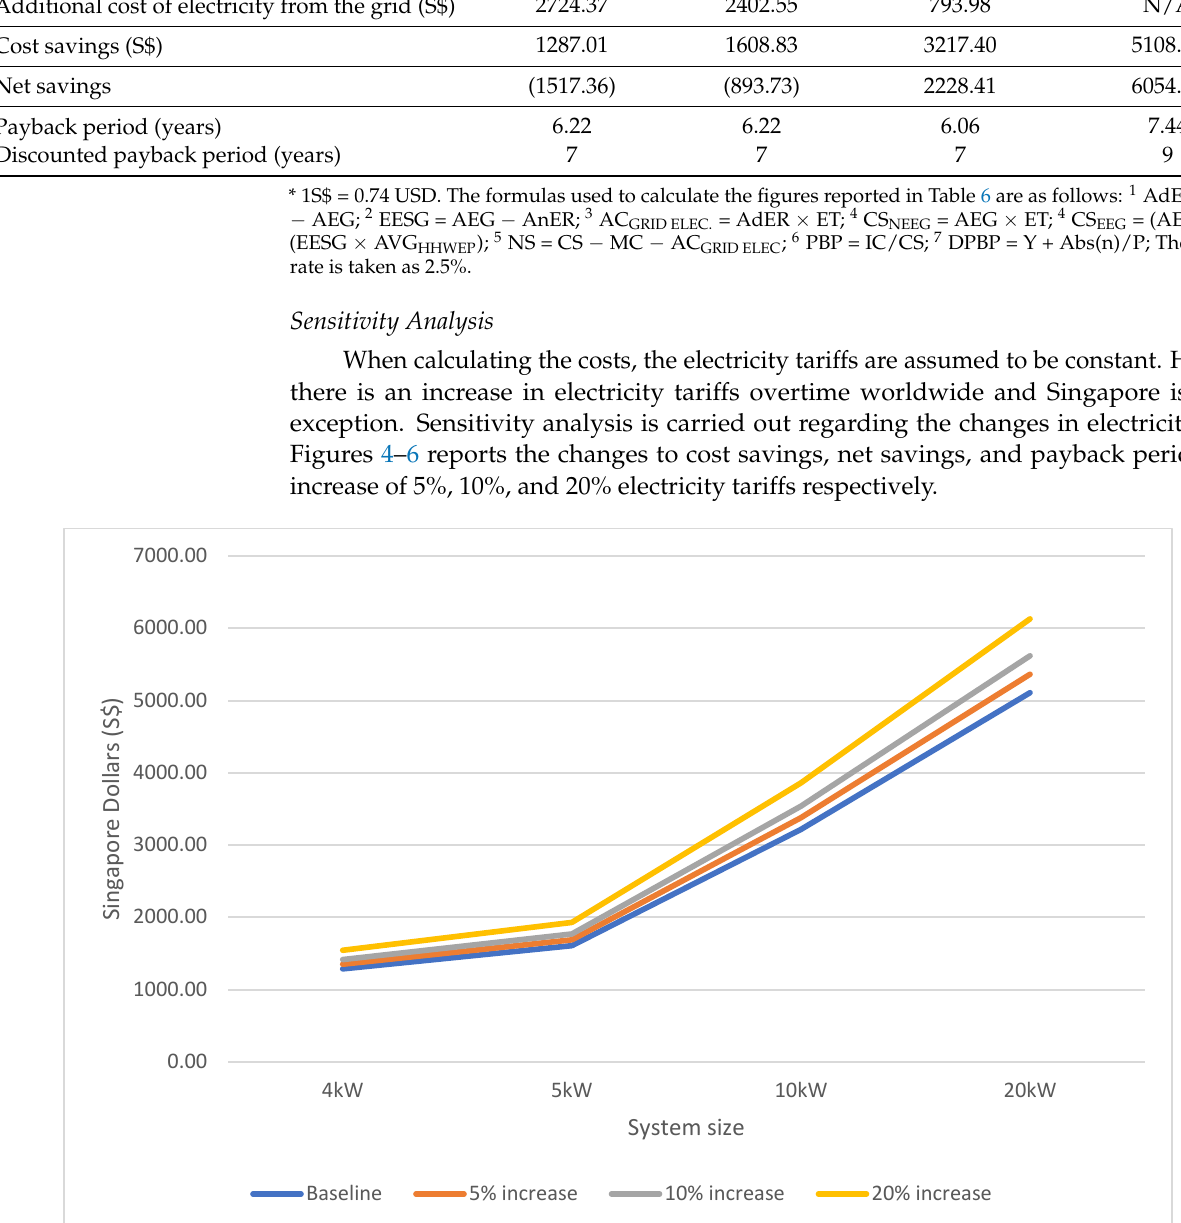
Figure 5. Changes to net savings to the changes in electricity tariffs. Net savings considered the actual savings after purchasing the additional electricity required. This also includes the maintenance cost of the system as well. Therefore, this figure gives an effective picture on the actual expenses and savings from each of the sys- tems. Systems with smaller system capacities, such as 4 kW and 5 kW, rely heavily on the grid. A significant portion of required electricity is taken from the grid. As a result, in a phase where the electricity prices are to escalate, lower capacity systems must pay more for the grid connected power (refer Figure 5). A system, e.g., 10 kW capacity, generates a